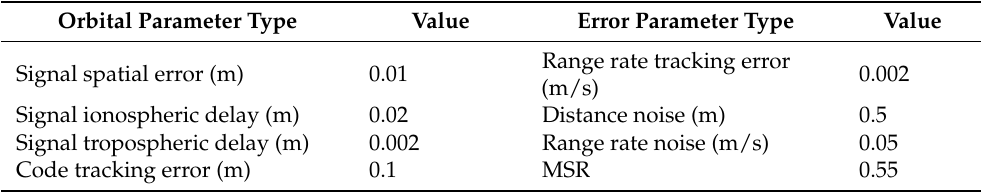
Table 3. Environmental parameters.